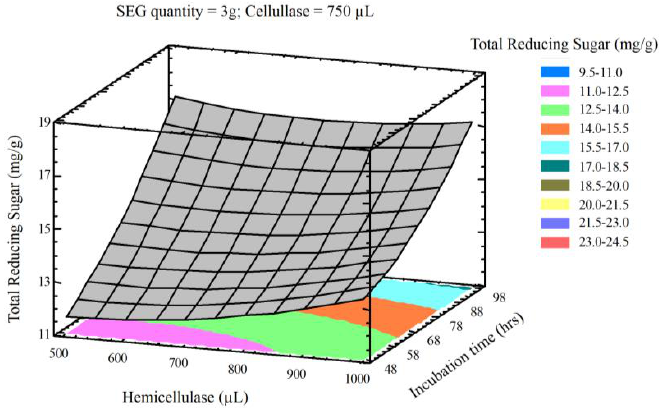
Figure 4. Three-dimensional response surface plot showing influence of incubation time (h) and hemicellulase (uL) loading when the response surface is fixed at SEG quantity (3 g) and cellulase = 750 uL.